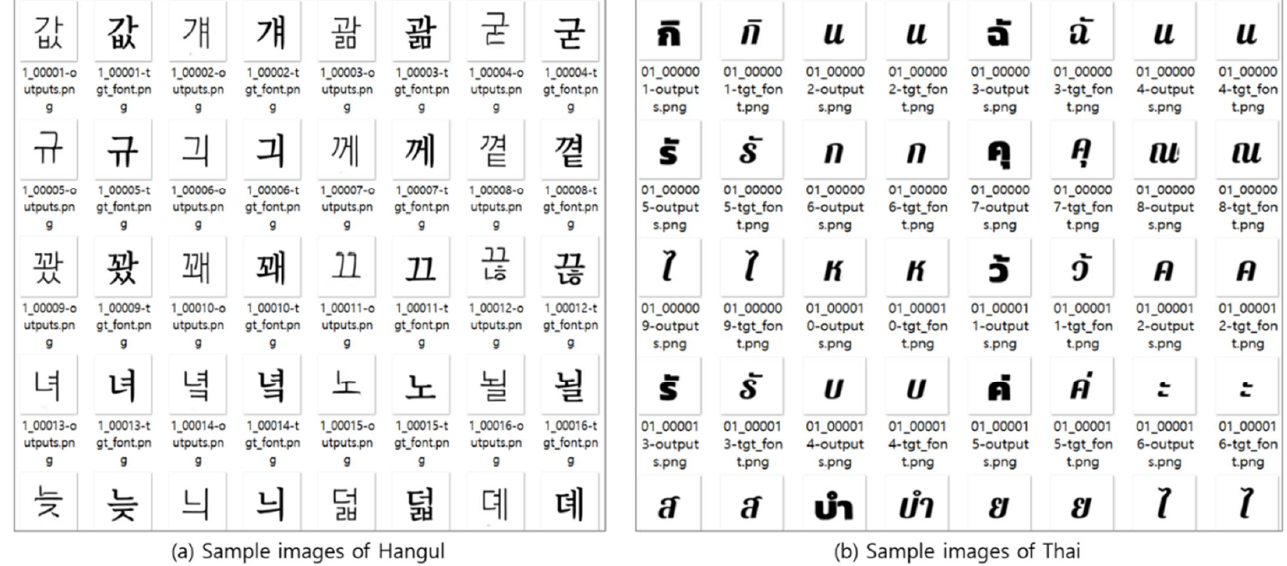
Figure 19. Sample images of Hangul and Thai characters generated by the CCFont Model.